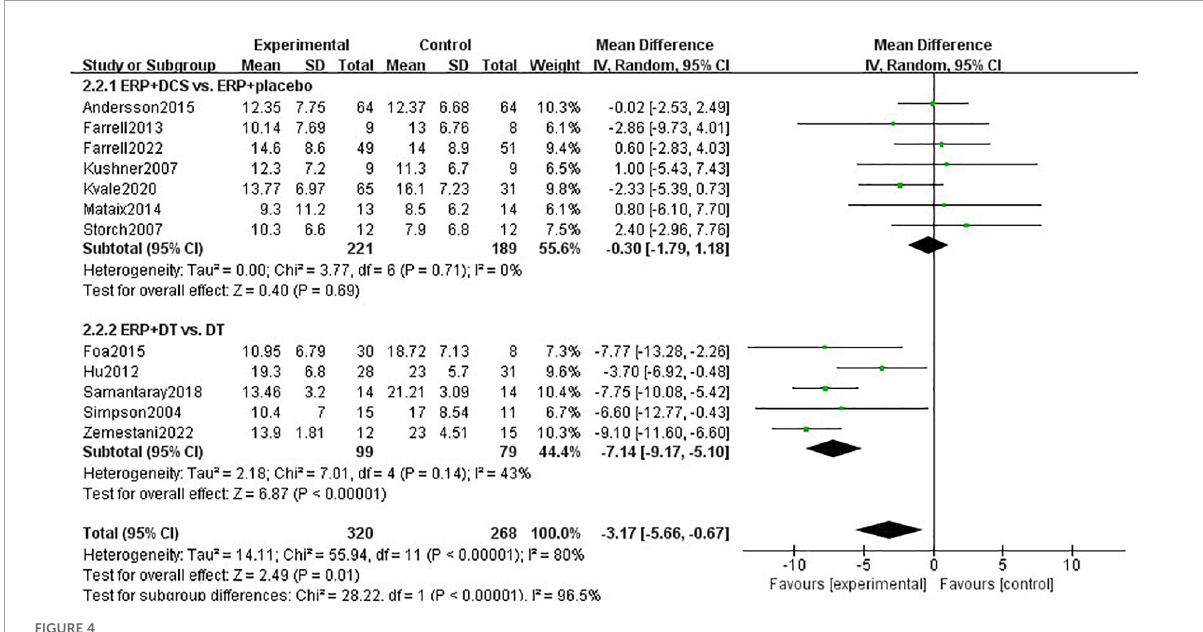
FIGURE4 Subgroup analysis of the effect of combination therapy on the intervention of obsessive-compulsive symptoms in patients with OCD during the follow-up period.